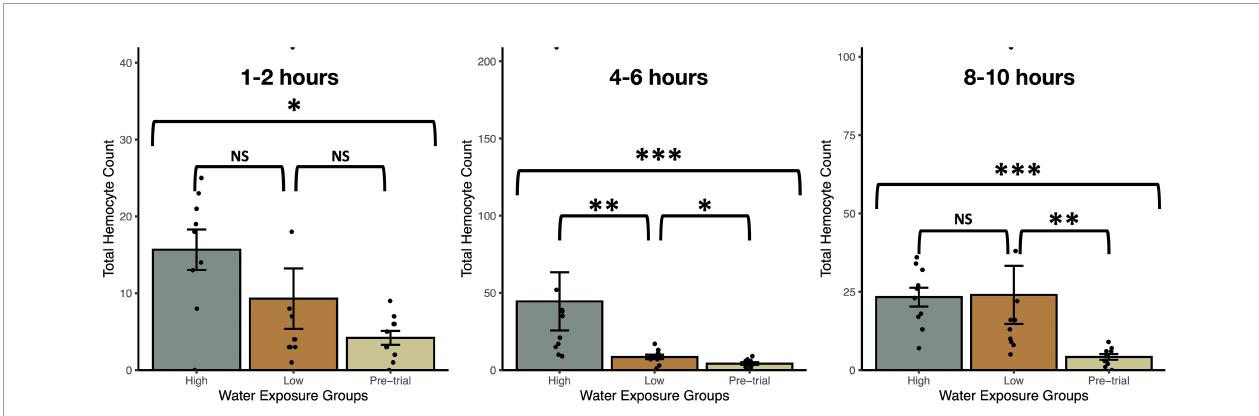
FIGURE 2 | Total haemocyte counts (mean ± SE) from uninfected Stagnicola elodes snails exposed to experimental (snail-conditioned water of low and high densities) and unexposed pre-trial snails over three exposure times. N.S, No signi fi cative difference; * P < 0.05, ** P < 0.01, *** P <